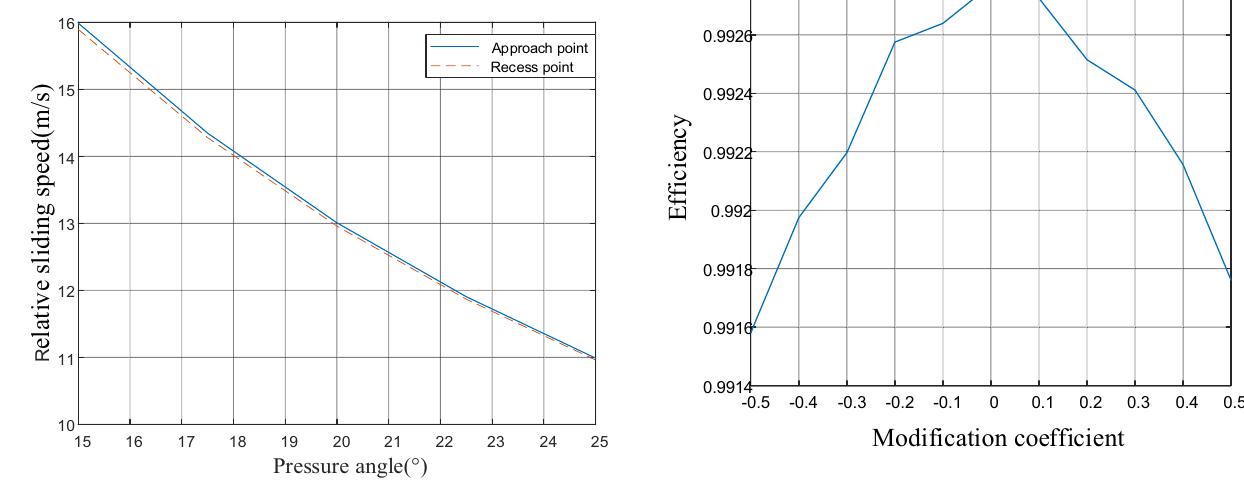
Fig. 12 Influence of pressure angle on relative sliding speed